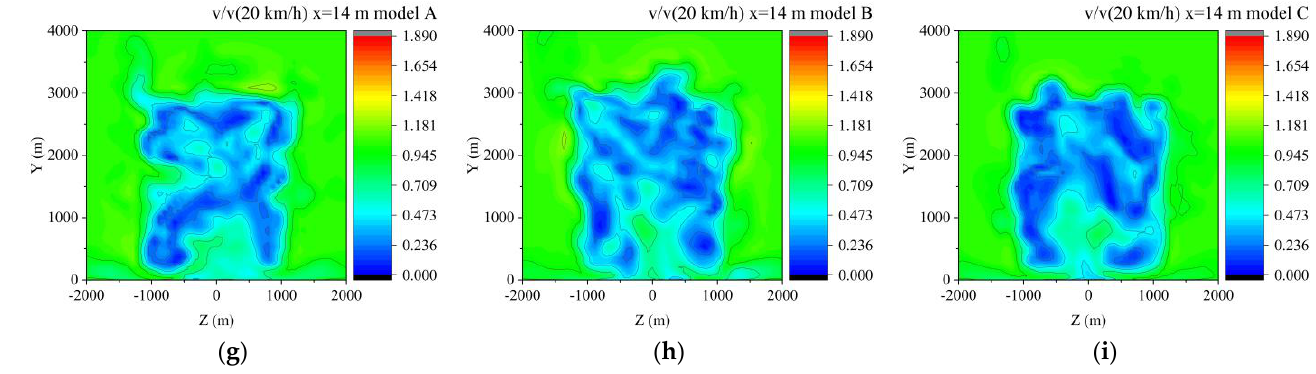
Figure 7. Vertical (Y-Z plane) velocity distribution for ( a ) model A at X = 12.5 m; ( d ) 13 m; ( g ) 14 m; ( b ) model B at X = 12.5 m; ( e ) 13 m; ( h ) 14 m; ( c ) model C at X = 12.5 m; ( f ) 13 m and ( i ) 14 m.